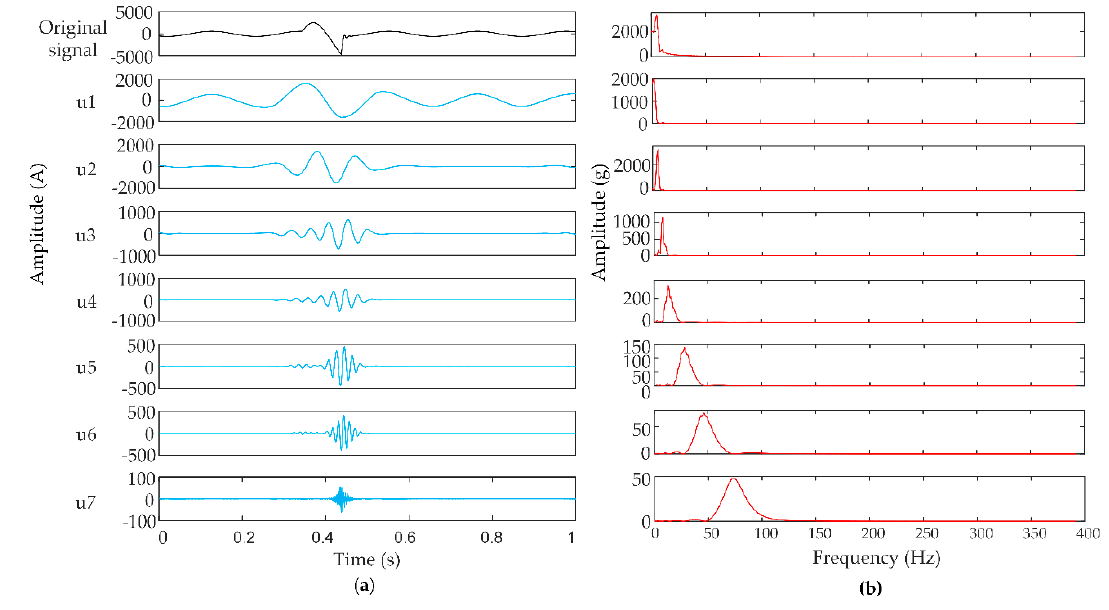
Figure 6. Results and spectra of VMD for multicycle incipient cable failure: ( a ) Modes; ( b ) Frequency spectra.